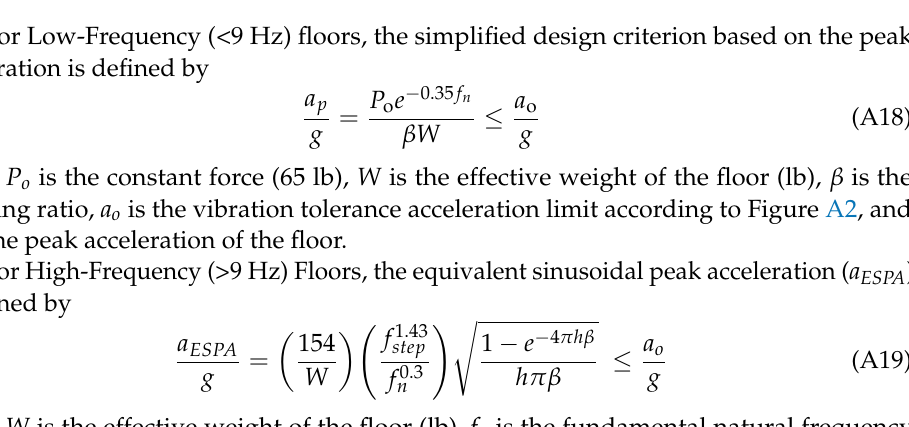
Figure A2. Recommended tolerance limits for human comfort as published in AISC design guide 11. Reproduced from [53] with permission.